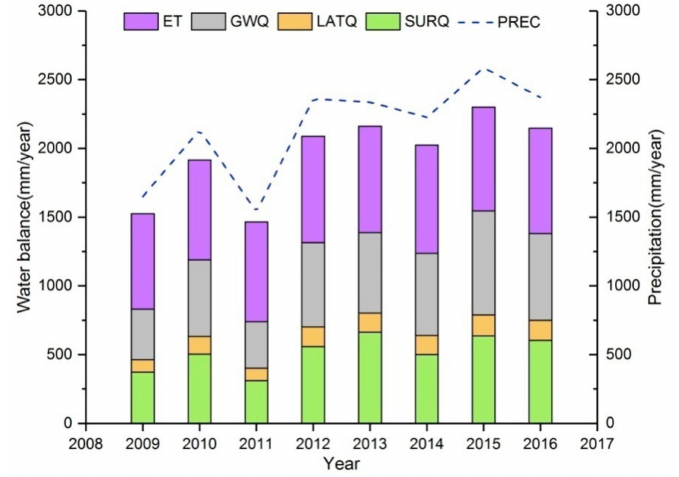
Figure 9. Annual change in contribution by the hydrological elements to the water budget.